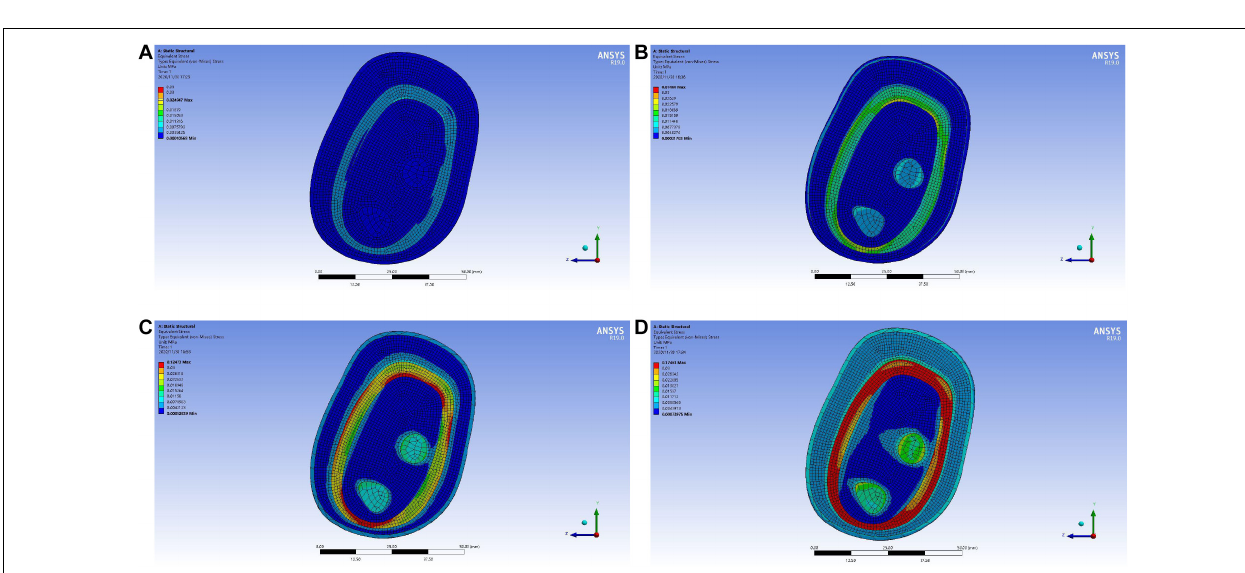
FIGURE 11 | Rainbow diagram of pressure distribution in the lymph and blood layers of the forearm model under different external pressure loads: (A) 001 MPa external pressure, (B) 0.003 MPa external pressure, (C) 0.005 MPa external pressure, and (D) 0.007 MPa external pressure.